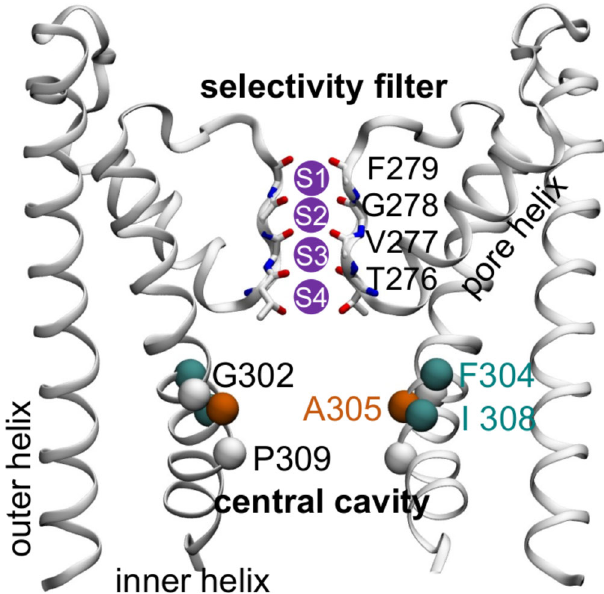
Fig. 1|StructureoftheporedomainofAplysiaBKchannel. Twosubunits ofthe tetramer are shown for clarity. The four potassium binding sites at the selectivity fi lterarelabeledasS1 – S4.Thebackboneoftheresiduesconstitutingtheselectivity fi lter, as well as the C α atoms of several residues from the inner helices critical for gating and ion conduction, are